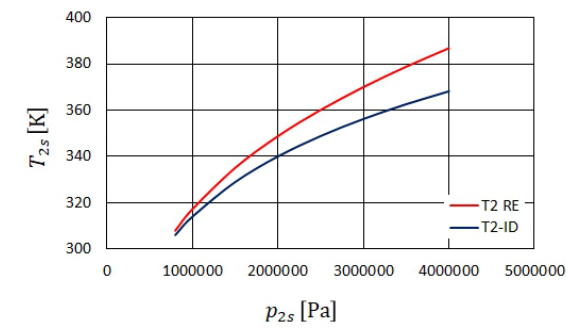
2 s calculated from